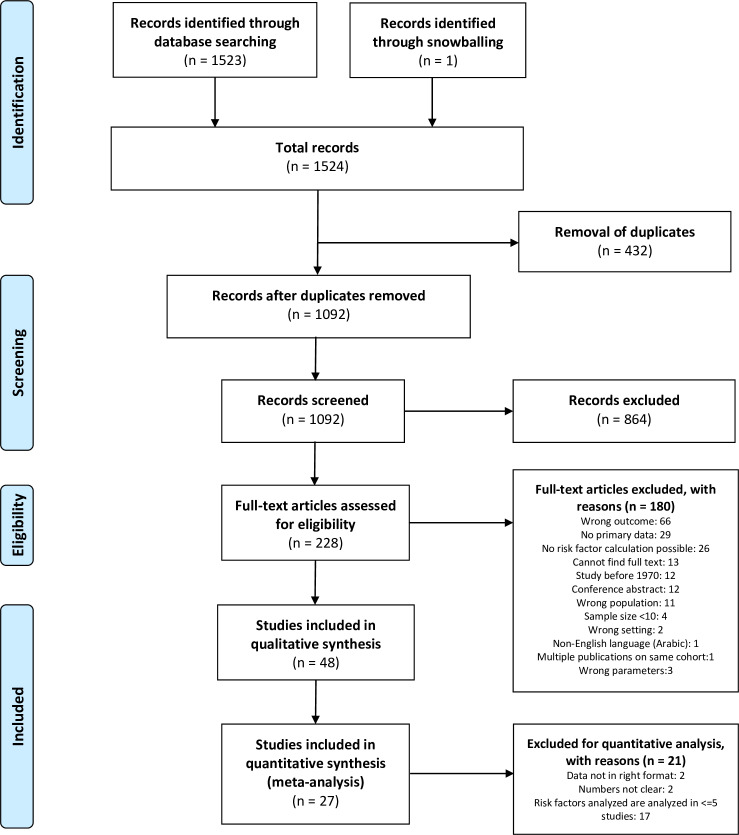
Flow diagram of the studies identified, screened, reviewed, and included in the systematic review and meta-analysis.